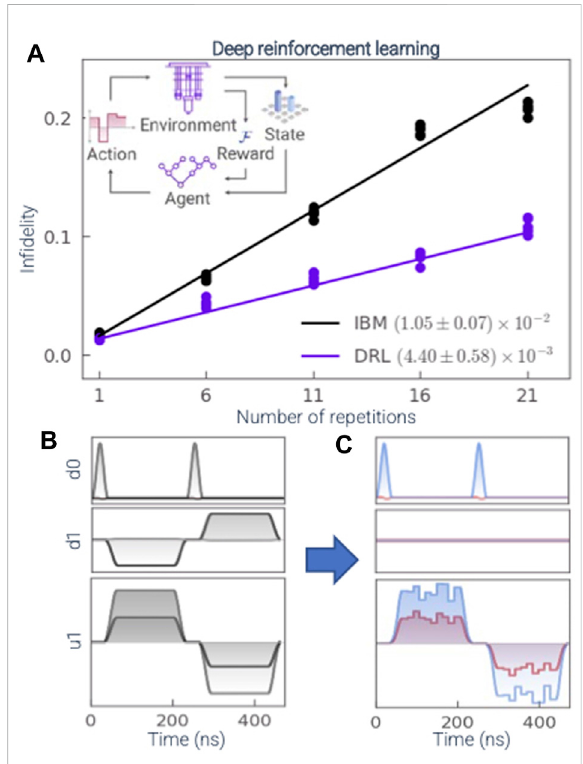
FIGURE 7 Optimization of a ZX ( − π /2) entangling gate for a superconducting device using a deep reinforcement learning (DRL) optimization routine (see inset for a diagram of the optimization cycle). (A) In fi delity measurement after different numbers of repeated application of the gate for the IBM default and DRL optimized gate. Approximate gate error is extracted from the slope of the in fi delity data. (B,C) Waveforms for the (B) IBM default and (C) DRL optimized ZX ( − π /2) gates. Note that channel d1, used as a cancellation tone in the IBM default is not used in the optimized gate